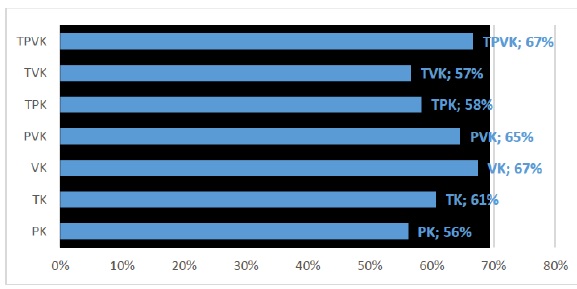
Figure 3: Percentage of point “4” to point ≥ 4 in secondary voca- tional non-ICT teachers